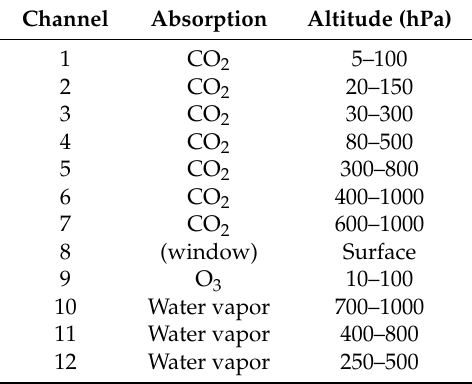
Table 1. Absorbents of HIRS longwave channels and the approximate broad layers where the channels